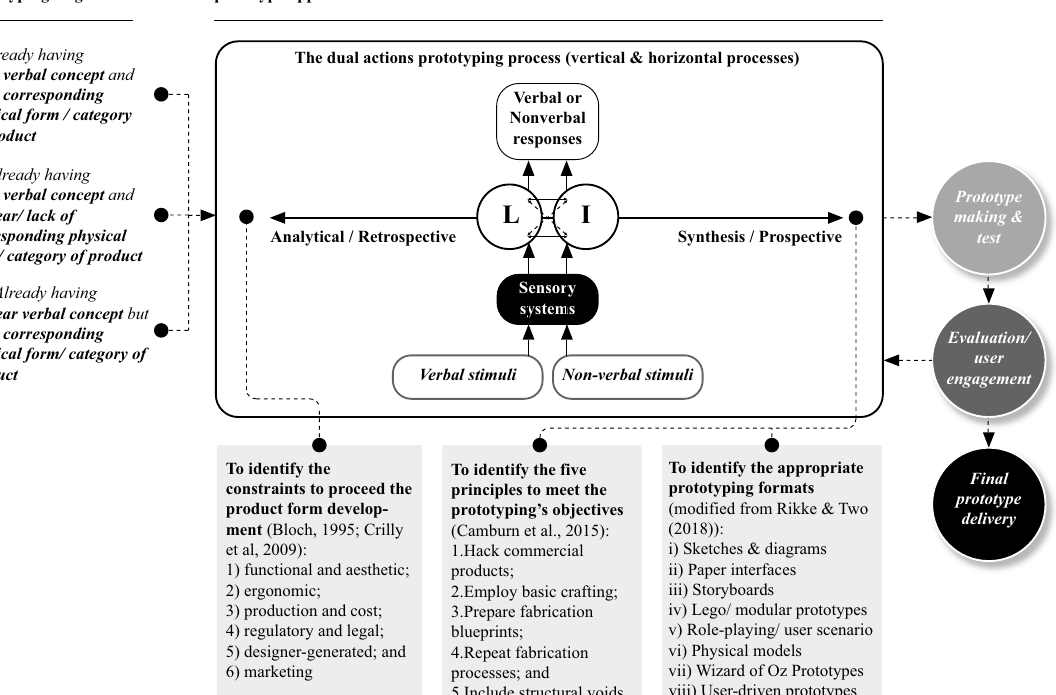
Figure 3 (top): The analytical/retrospective and synthesis/ prospective swinging action diagram. The vertical path indicates the dual coding system from sensory stimulus to the responses of a designer. The horizontal dimension with two ends indicates the intentions of the designer who either operates the analytical-prototyping or synthesis-prototyping.